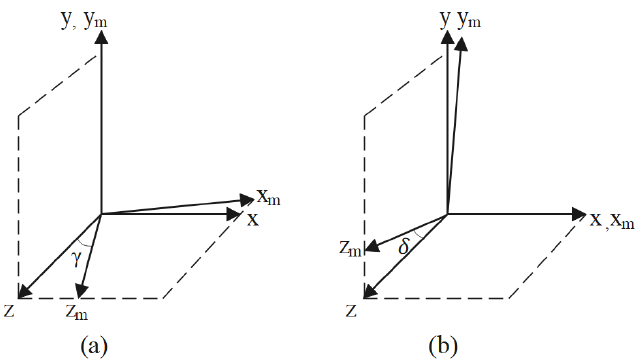
Figure 4. Illustration of coordinate systems for simulation of misalignment: ( a ) in-plane angular misalignment and ( b ) out-of-plane misalignment.